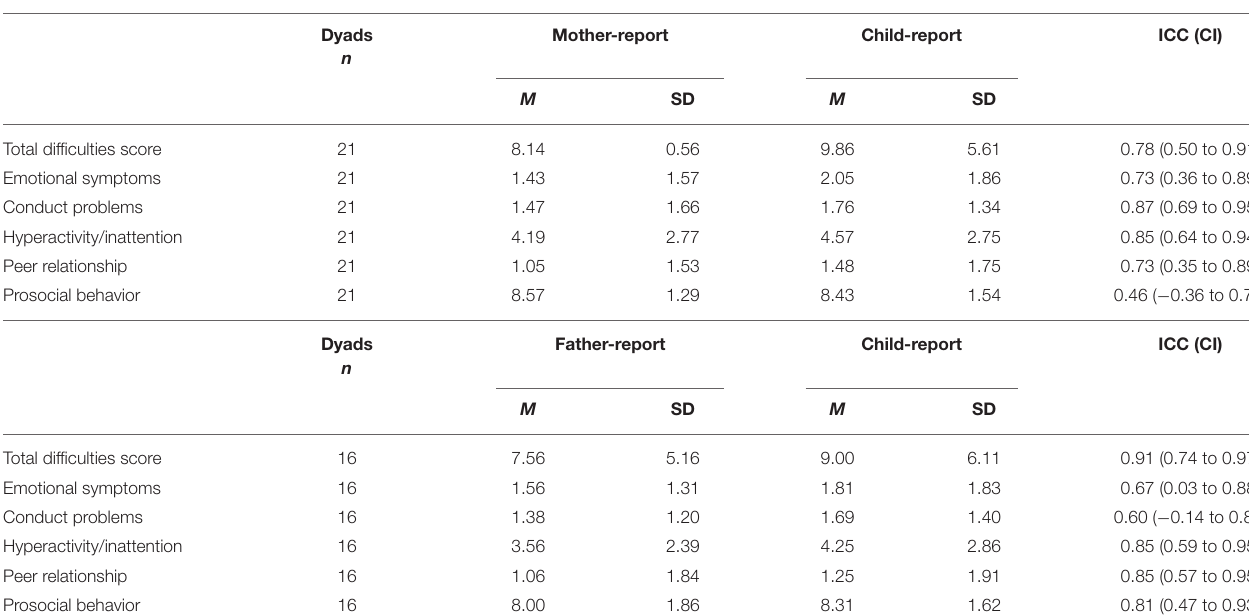
TABLE 5 | Inter-rater reliability.